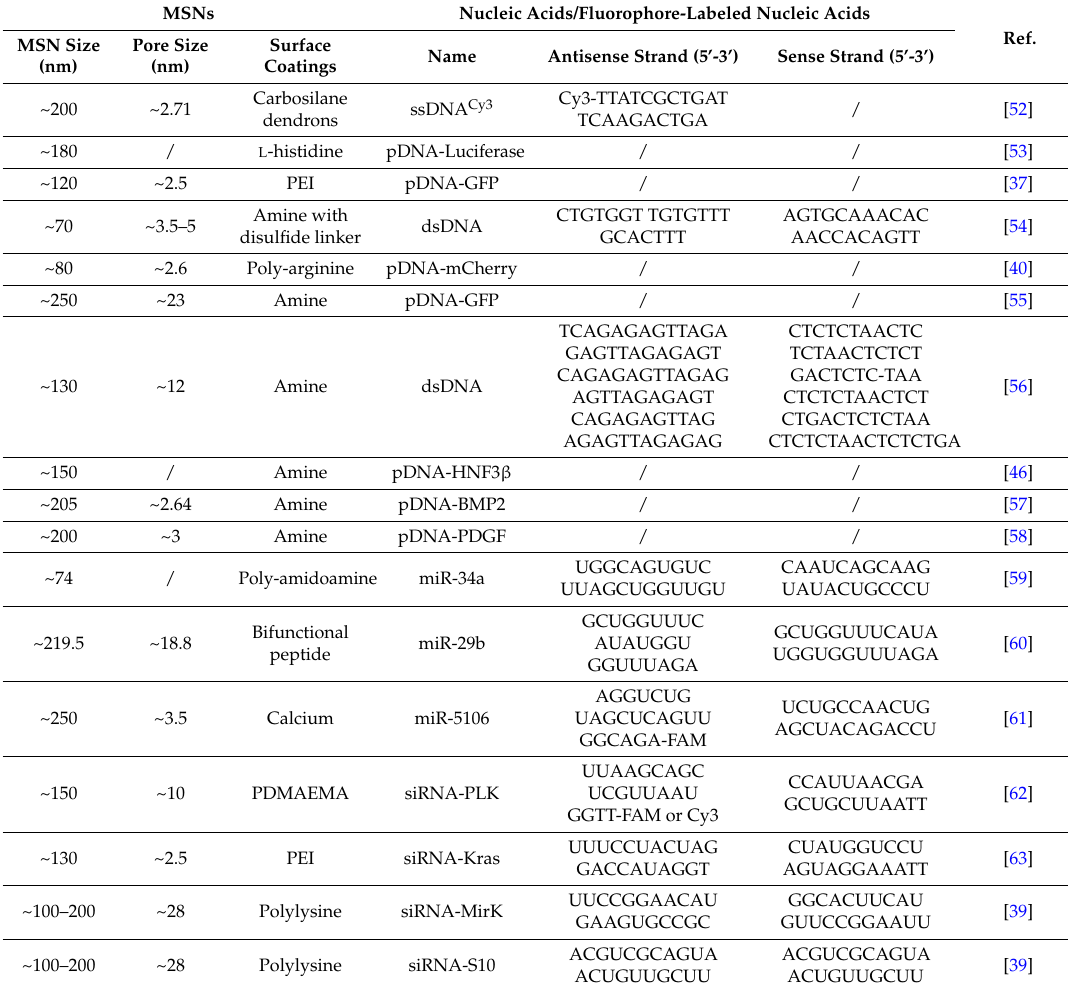
Table 1. Properties of MSNs and sequences of short oligonucleotides mentioned in this section. MSNs Nucleic Acids/Fluorophore-Labeled Nucleic